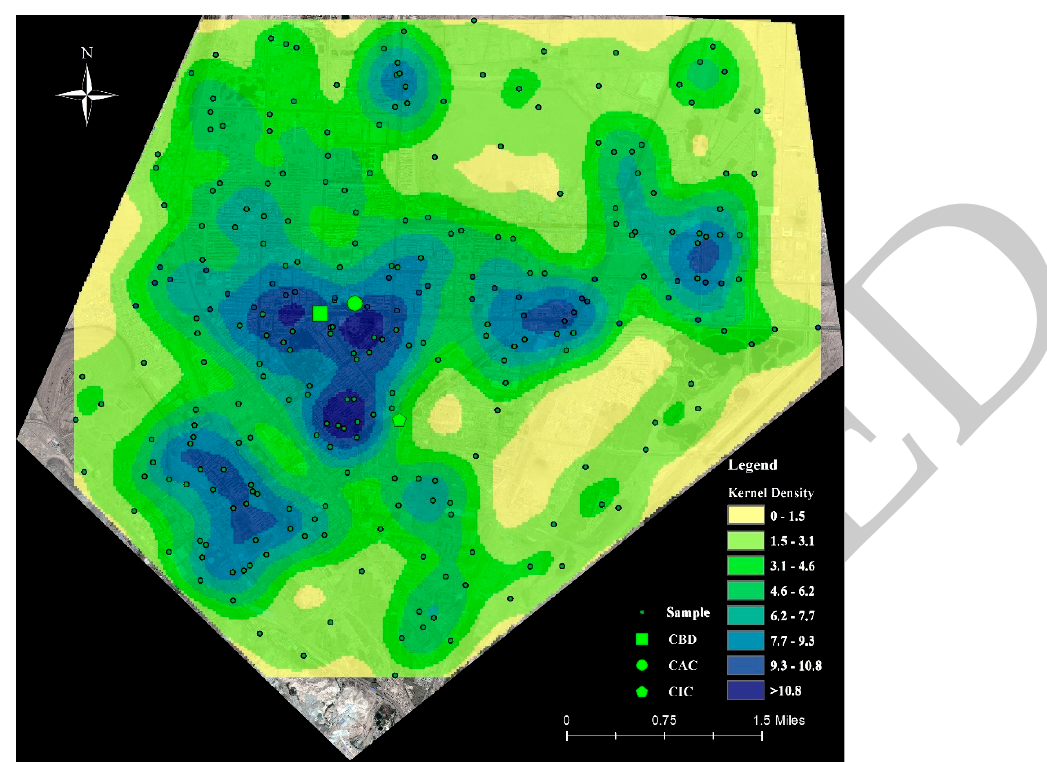
Figure 5. Kernel-density distribution map of sample cumulative metabolism.